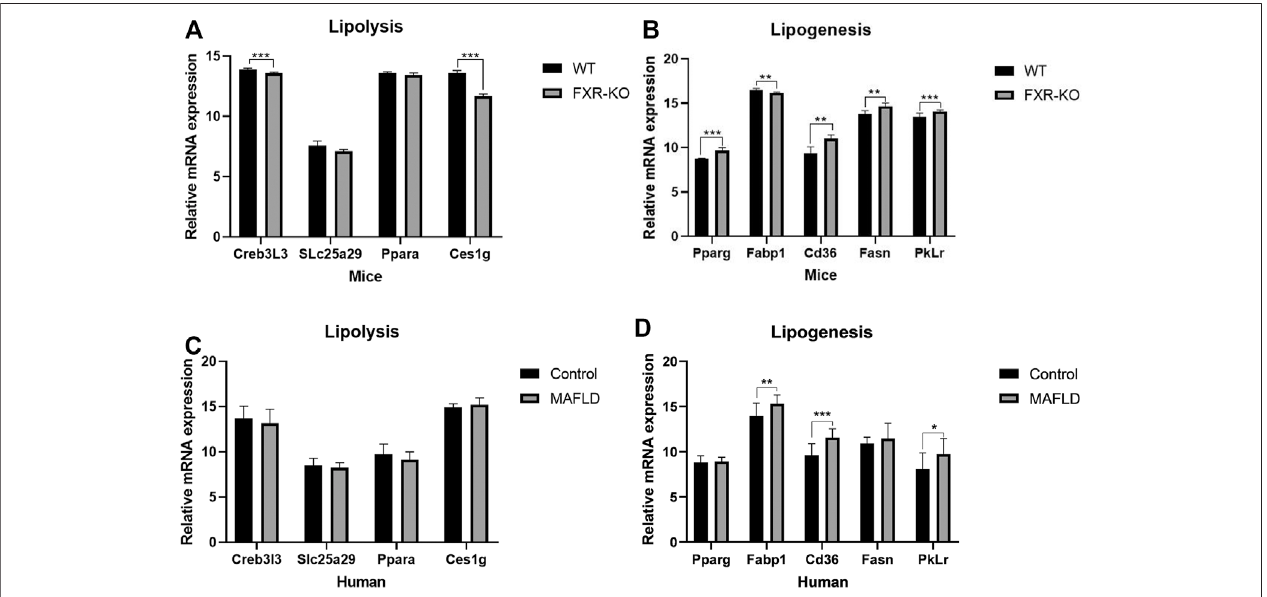
FIGURE 2 | The expression of lipid metabolism genes was altered in patients/mice with MAFLD. (A,B) Expression of genes involved in de novo lipogenesis, β -oxidation, and lipolysis measured by qPCR. (* p < 0.05; ** p < 0.01; *** p < 0.001).